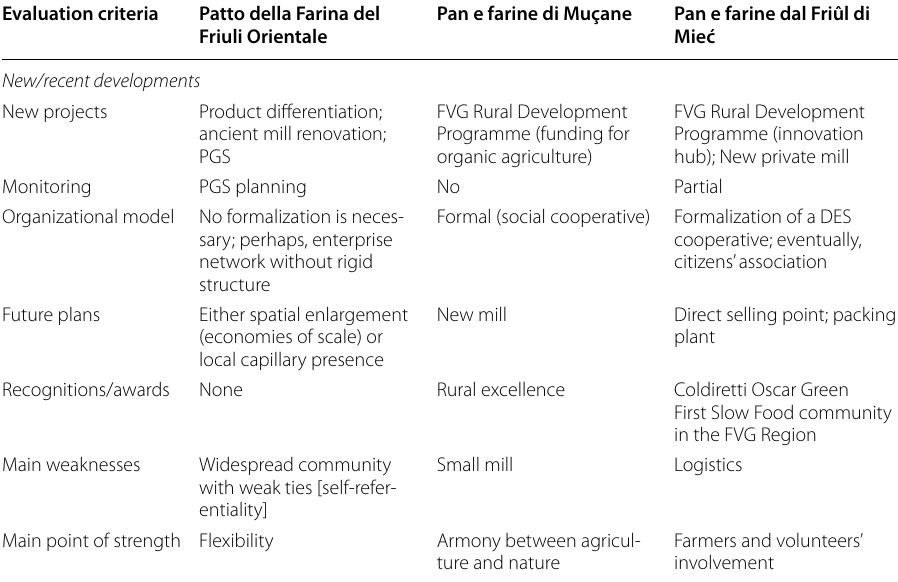
Table 6 New/recent development Evaluation